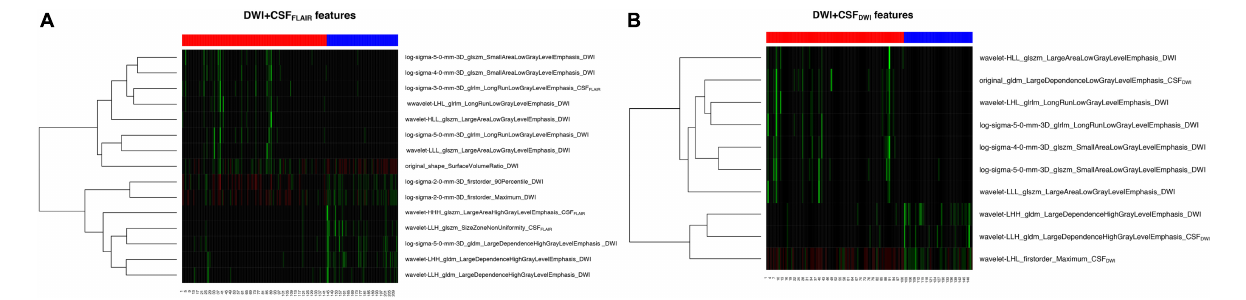
3 CSF FLAIR features in DWI + CSF FLAIR features ( Figure 3A ) and 7 DWI features and 3 CSF DWI features in DWI + CSF DWI features ( Figure 3B